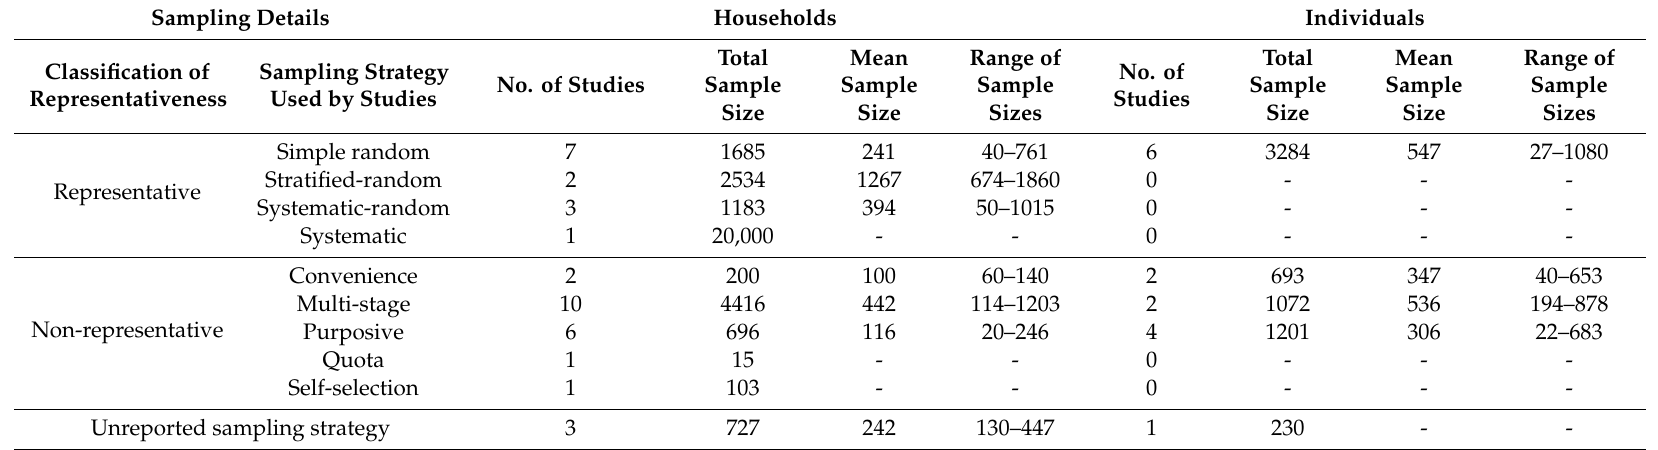
Table A3. Details of the sample sizes and their representativeness as reported by each published